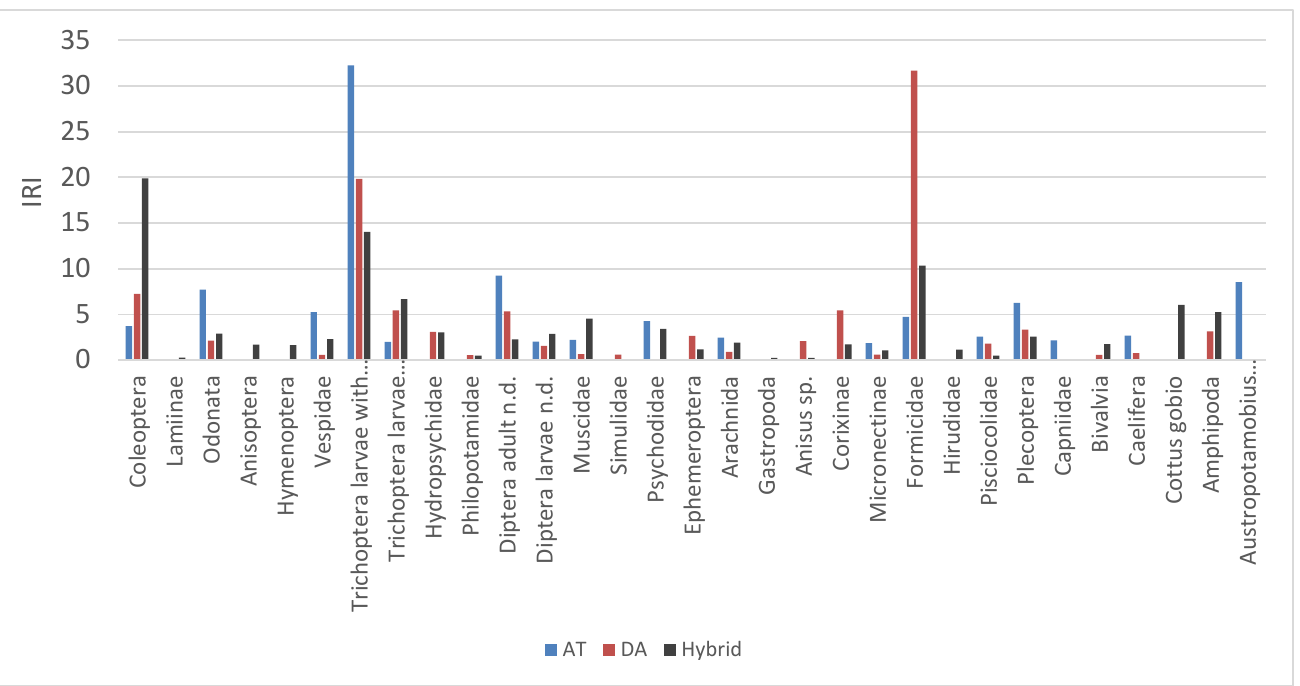
Figure 4. IRI prey importance for the AT and DA lineages and hybrids of brown trout from the Žumberak, Gorski Kotar and Papuk Mountains. Table 3. Schoener index (α) results based on the IRI of feeding overlap between brown trout of Atlantic (AT) and Danube (DA) lineages and their hybrids (HY) (* p < 0.05).